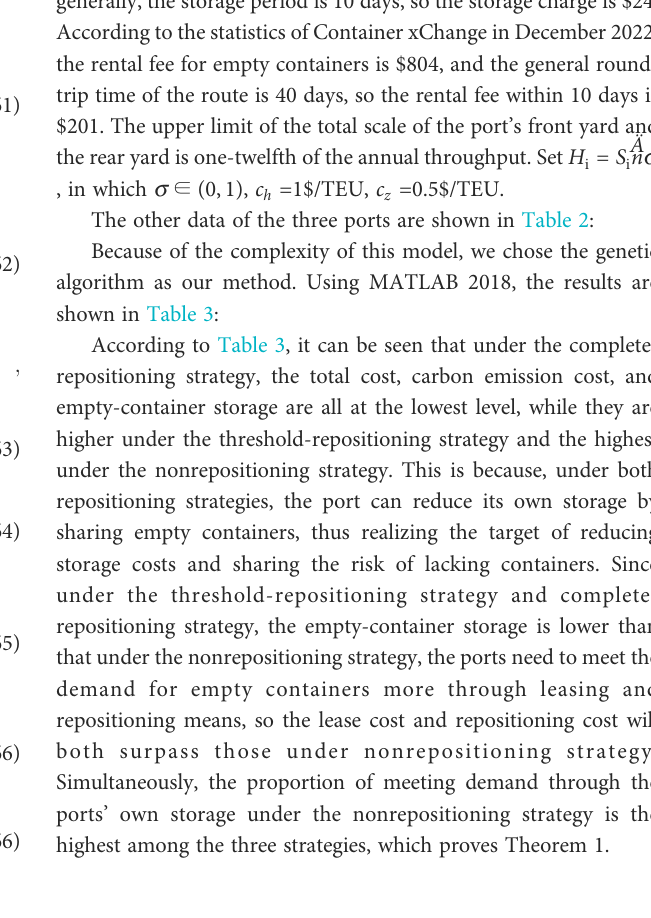
TABLE 1 Distances and repositioning costs among three ports ( n mile